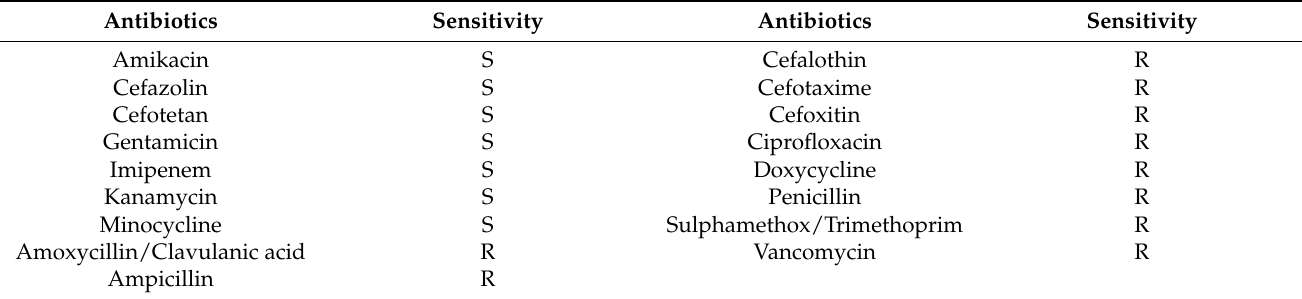
Table 1. Antibiotic sensitivity results of Nocardia africana in this